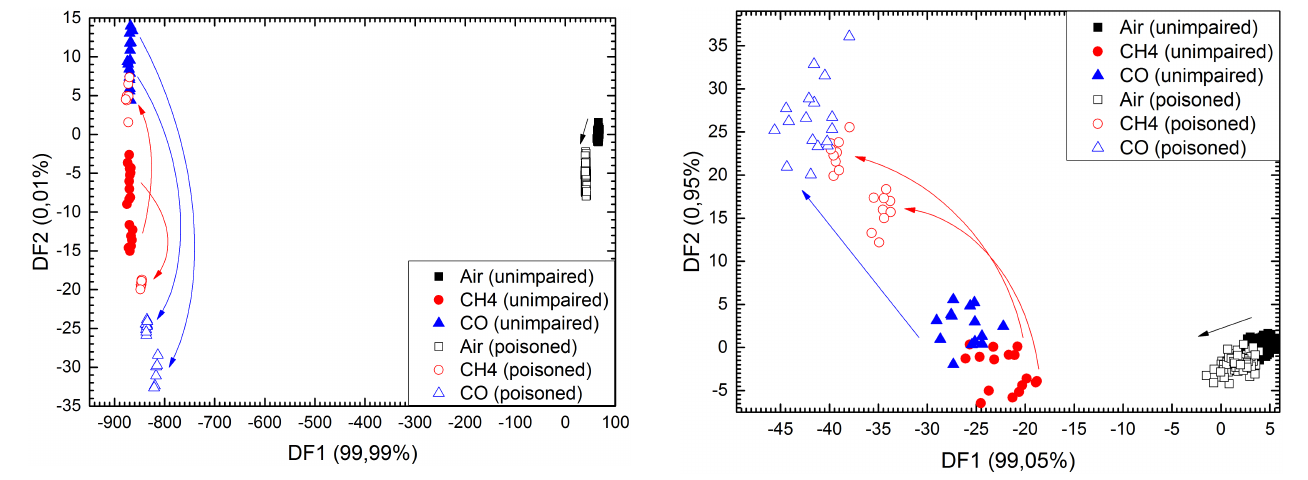
Figure 8. LDA of 10 EIS features (mean values/slopes) for unim- paired (solid symbols) and poisoned (open symbols) sensor, ac- quired with Agilent 4294A impedance analyzer. Table 2. Results of leave-one-out cross validation using a kNN clas- sifier ( k = 3) with Euclidian distance.